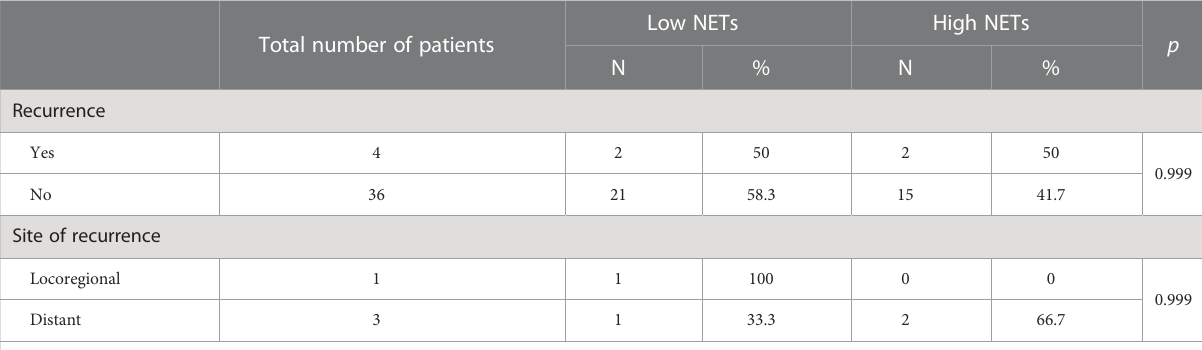
TABLE 3 Recurrence and circulating NETs levels.*